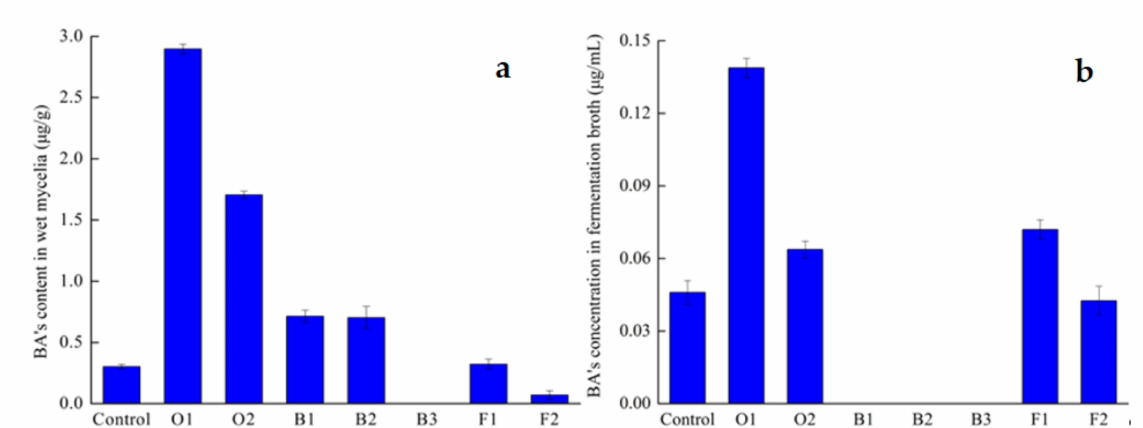
Figure 1. Effects of different exogenous inducing factors on the induction of BA’s content in wet mycelia ( a ) and fermentation broth ( b ). O1, oleic acid 1.0 g/L; O2, oleic acid 2.0 g/L; B1, betulin 10 mg/L; B2, betulin 25 mg/L; B3, betulin 40 mg/L; F1, fungal elicitor 45 mg/L; F2, fungal elicitor 90